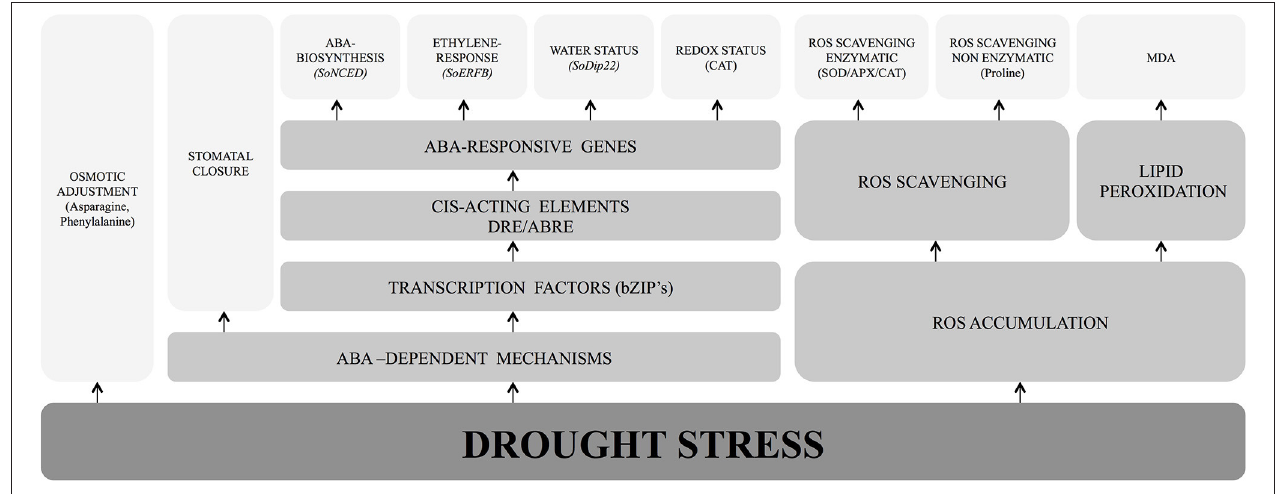
FIGURE 3 | Key components of sugarcane responses to water